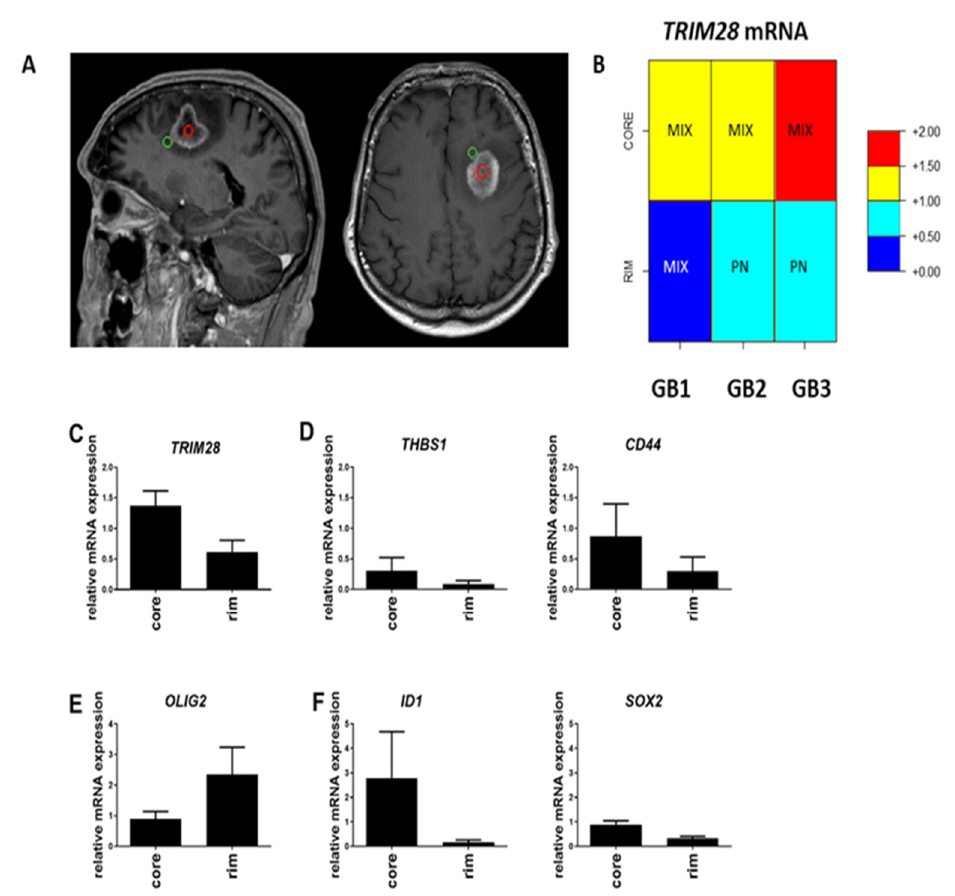
Figure 2. Gene expression analysis of the GB core versus rim areas. ( A ) T1-weighted MRI scans of a representative patient GB3, with multi-region surgical sampling. Regions include central enhancing core in red circle and rim area as the invasive edge in green circle, defined by the 5-aminolevulinicacid (5ALA) fluorescence positive area beyond the enhancement, according to the image guidance navigation system. ( B ) GB subtype analysis of core and rim areas in three GB samples (GB1, GB2 and GB3). High or low expression of TRIM28 within those areas is scaled in colours, representing relative expression (normalisation) of mRNA levels of TRIM28 gene vs. the mean of two housekeeping genes, HPRT1 and GAPDH. The red colour in Figure 2B visualizes relatively higher levels of TRIM28 mRNA expression (>1), while the blue colour indicates lower TRIM28 mRNA values (<1), and these are clearly separated in the rim vs. core tissues, shown separately in each GB1, GB2 and GB3 samples. ( C ) Expression of TRIM28 , ( D ) MES subtype genes ( THBS1, CD44 ), ( E ) PN subtype gene OLIG2 , and ( F ) GSC genes ( ID1 , and SOX2 ), were analysed in GB tissue core and rim areas, by RT-qPCR. mRNA values were normalized to housekeeping genes HPRT1 and GAPDH and analysed with quantGenius software [42]. Presented results are the mean ± S.D. of three GB samples.